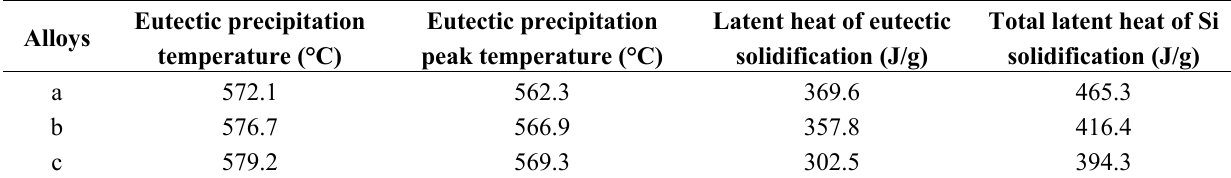
Table 2 Some crystallization parameters of eutectic Si by DSC